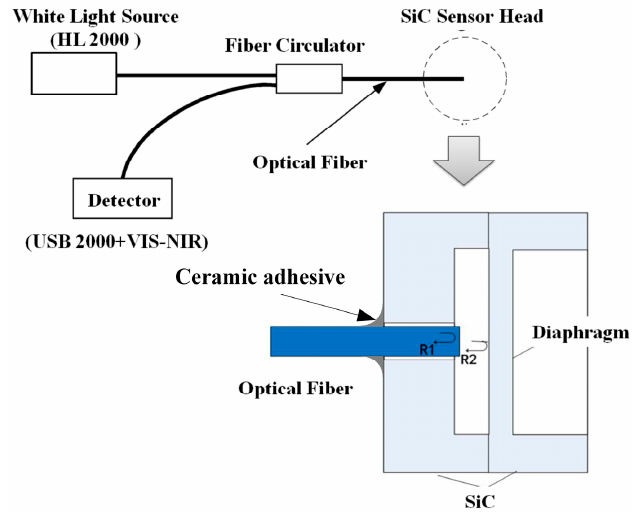
Figure 1. Schematic illustration of the silicon carbide (SiC) sensor head and the measurement scheme.